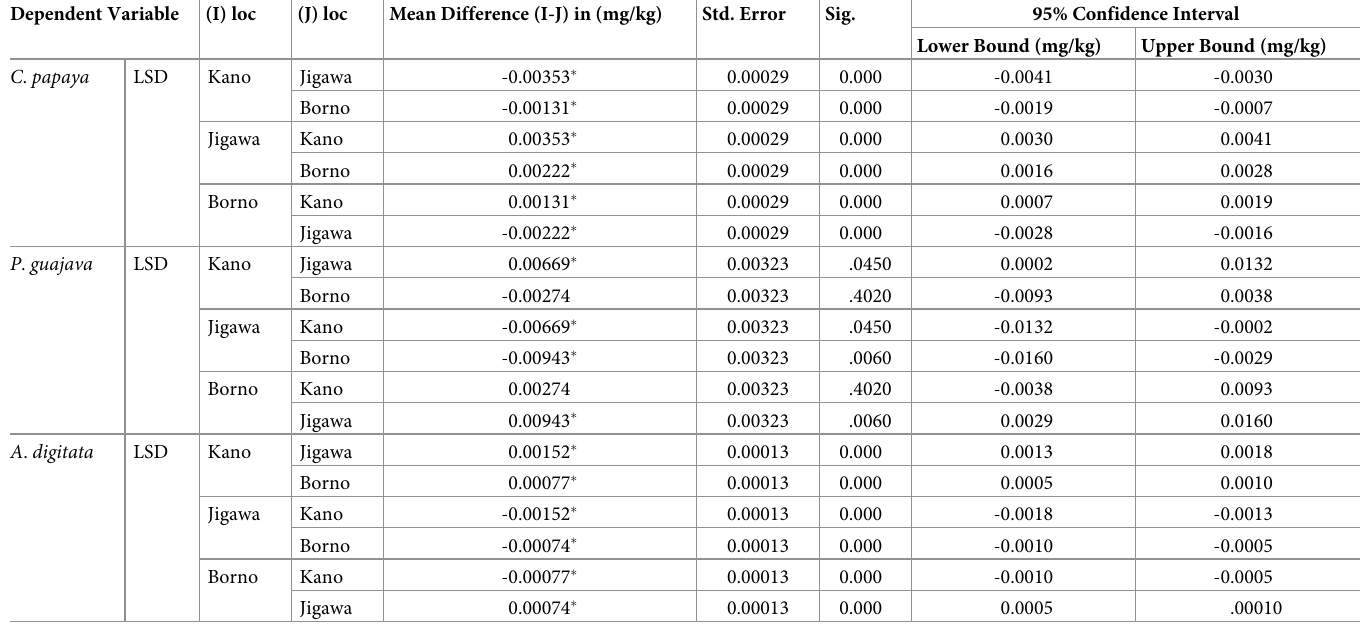
Table 8. Multiple comparisons table for Cd. Dependent